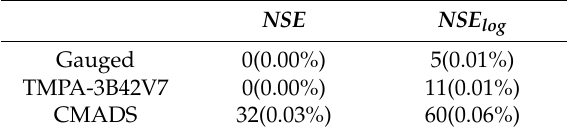
Table 10. Number (percentage) of behavioral parameter sets for the Sacramento